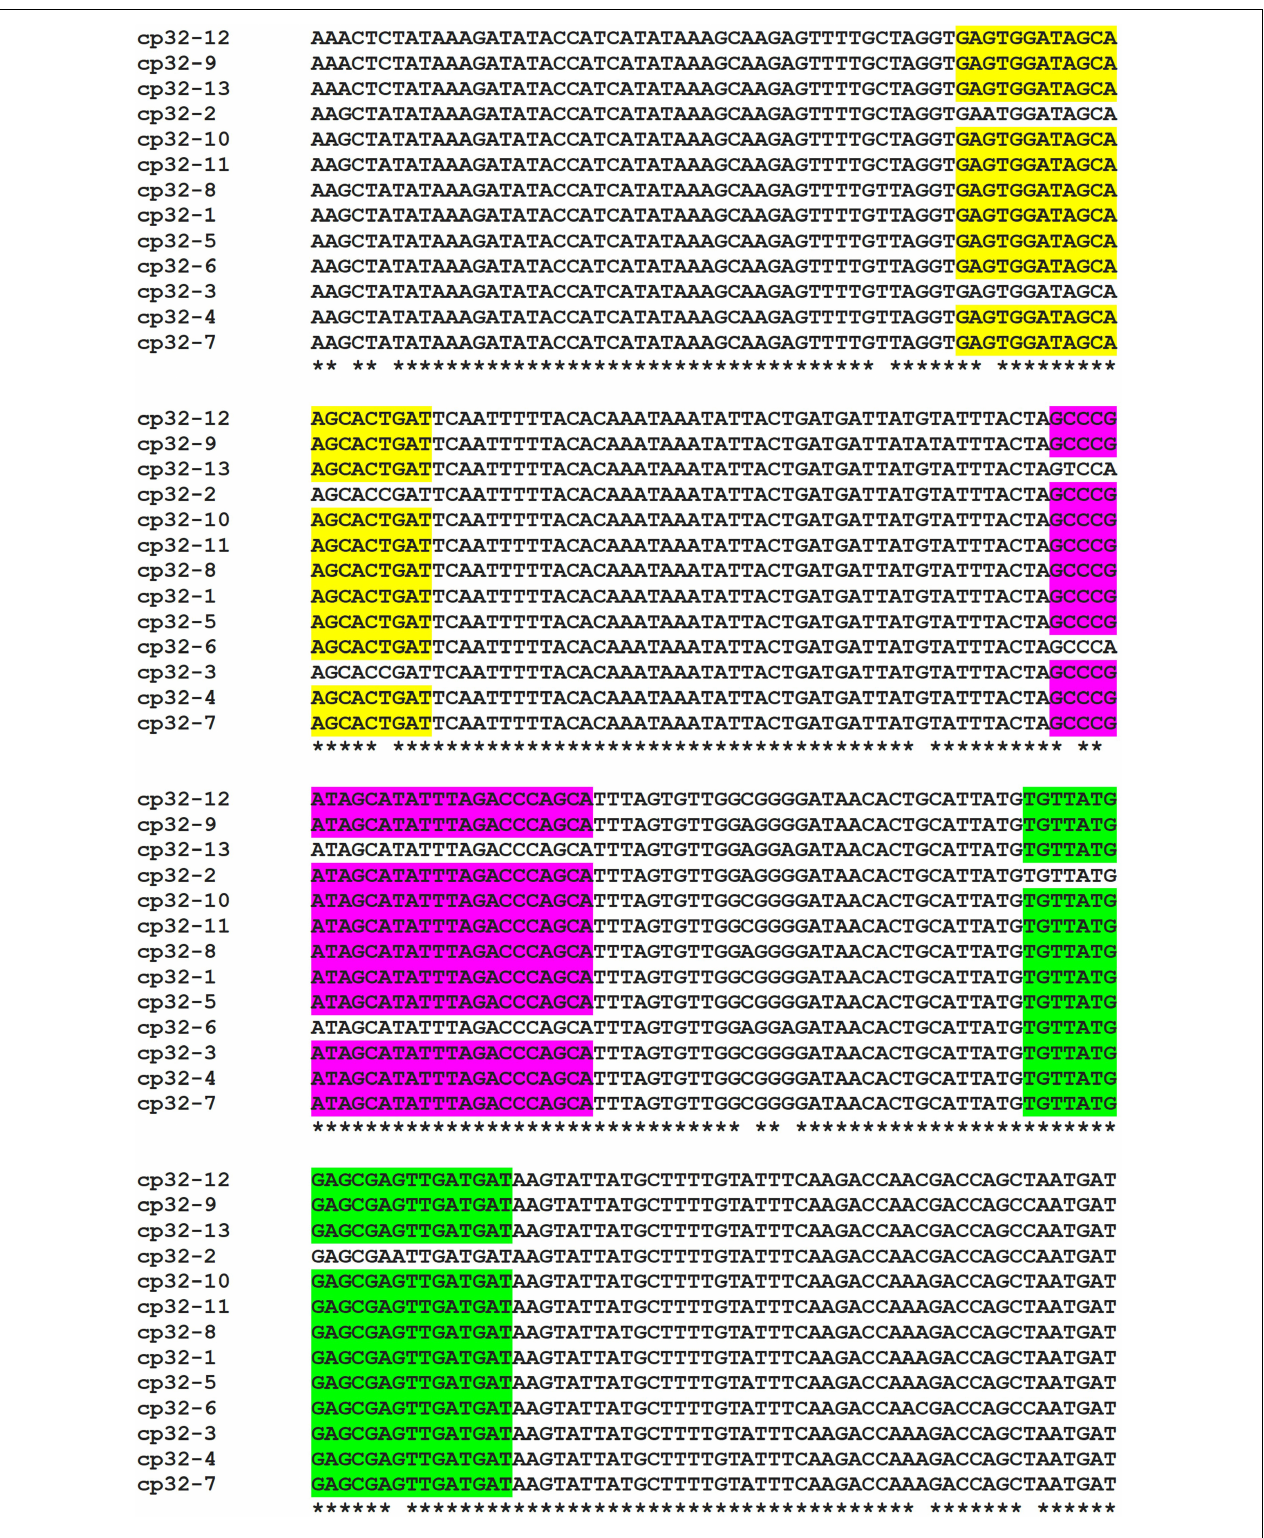
FIGURE 2 | Alignment of the terL gene sequence located on the 13 cp32 plasmids (cp32-1 to cp32-13). Identical nucleotides are indicated with an asterisk. Conserved regions of the forward and reverse primers, and probe are highlighted in yellow, green and purple, respectively. Identical primer/probe sequences are present in nine of the terL genes, except for those of the cp32-2, cp32-3, cp32-6, and cp32-13 plasmids.